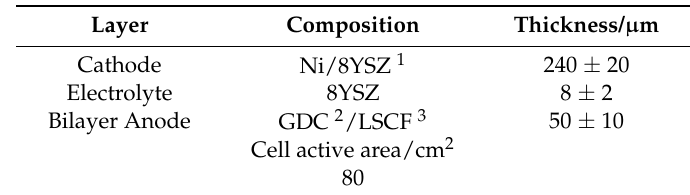
Figure 2. Lay-out of SOE stack test station. Table 1. Electrolytic cell components